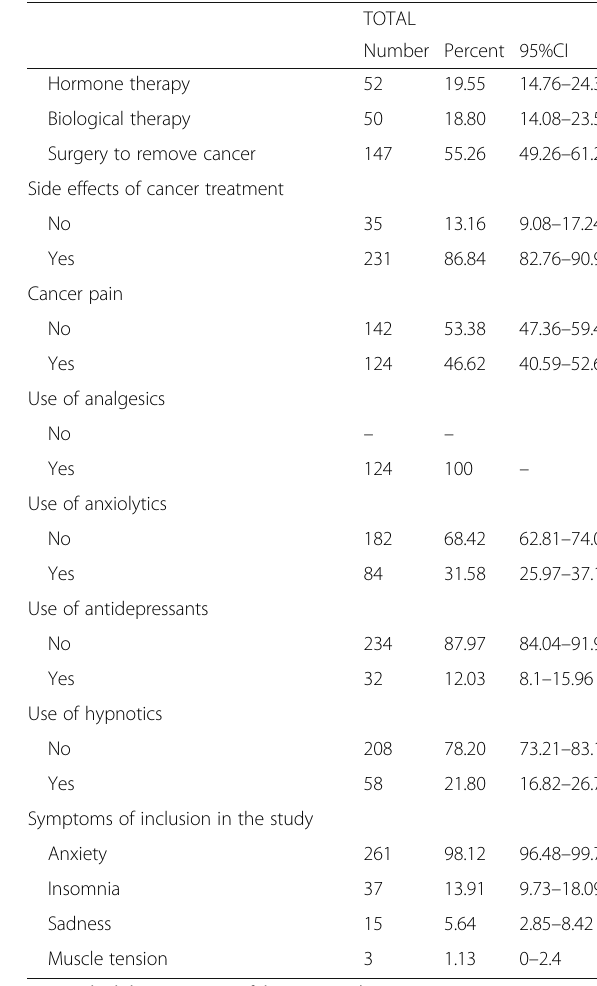
Table 1 Sociodemographic, medical characteristics on study participants